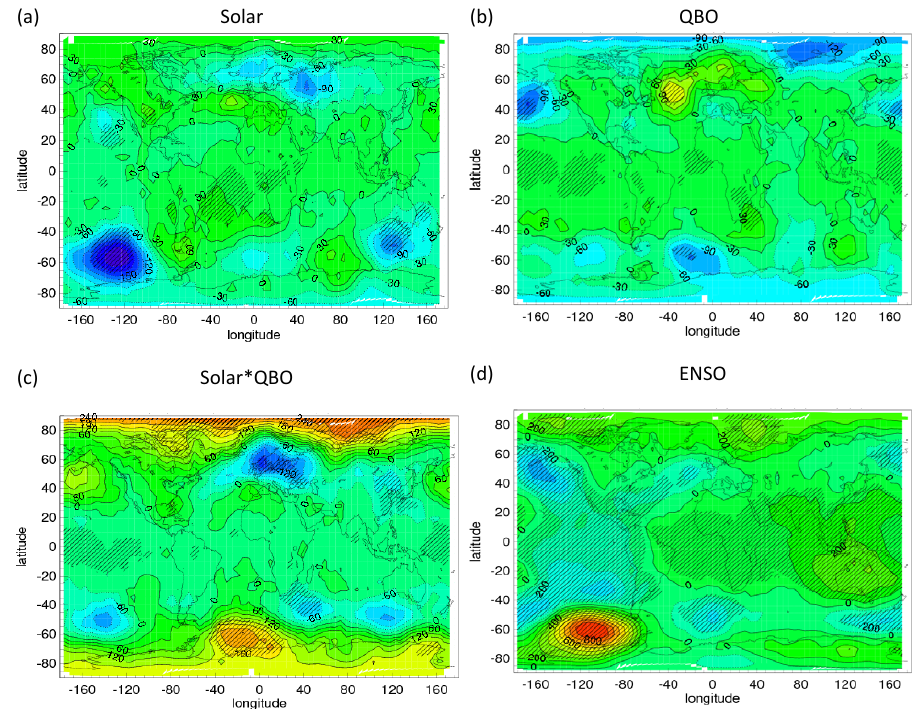
Fig. 3. Results of multiple linear regression analysis of sea level pressure data 1953–2004. Components (Pa) due to (a) Solar (SSN); (b) ENSO; (c) QBO (at 50hPa) Results of a separate analysis in (d) show the compound Solar*QBO (at 50hPa) signal. Dashed lines indicate negative values; hatching indicates areas assessed statistically significant at the 5% level. Contour interval in (a) , (b) and (c) is 30Pa and for (d) 100Pa. The same colours are used each side of the zero contour in all panels.